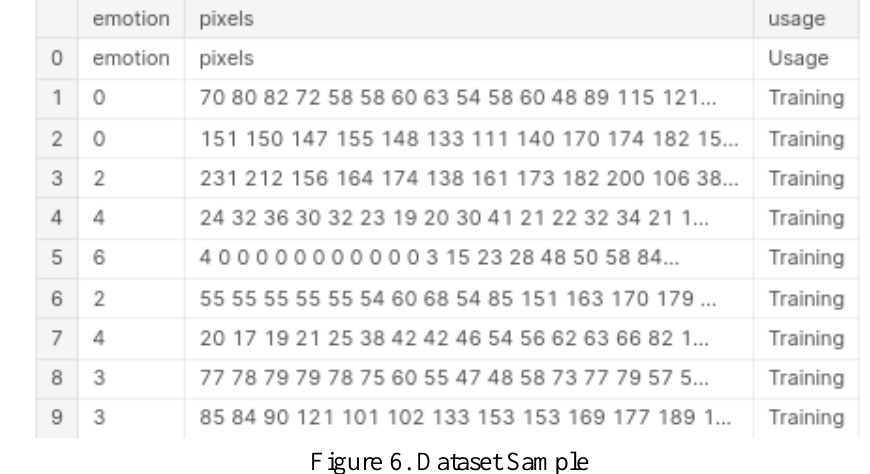
Figure 6. Dataset Sample